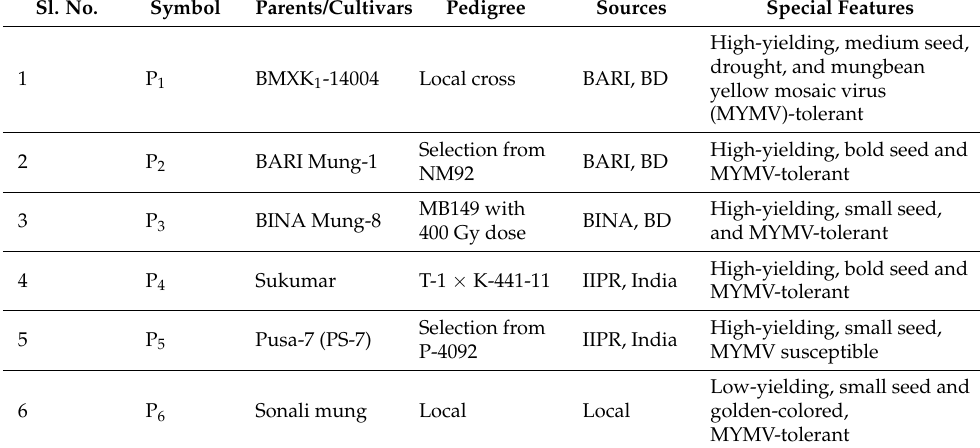
Table 8. Diallel crosses and their cross